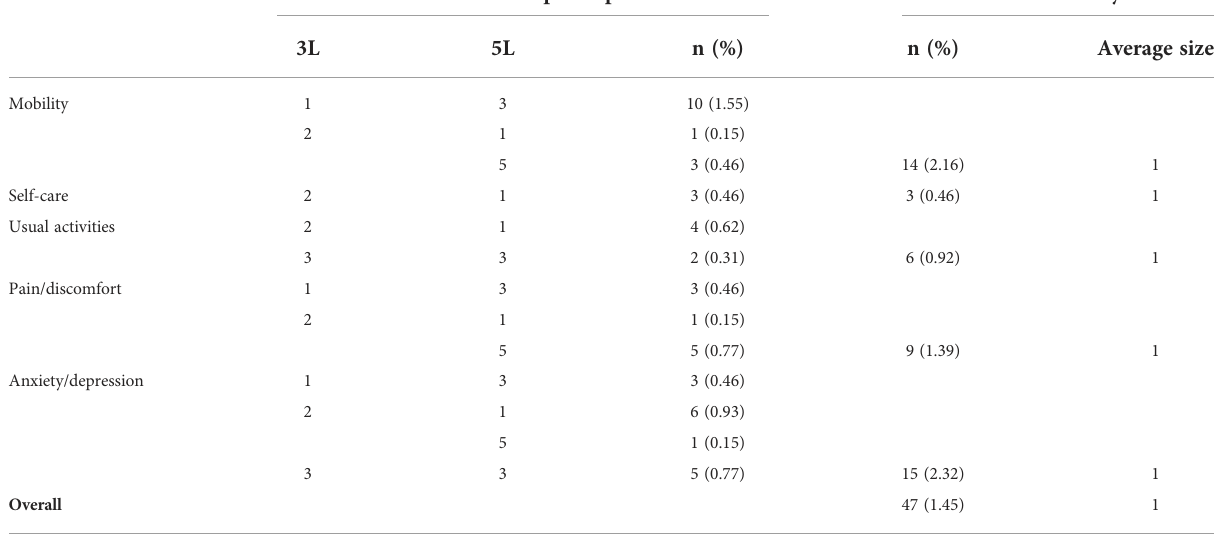
TABLE 3 Inconsistency properties of the 3L and